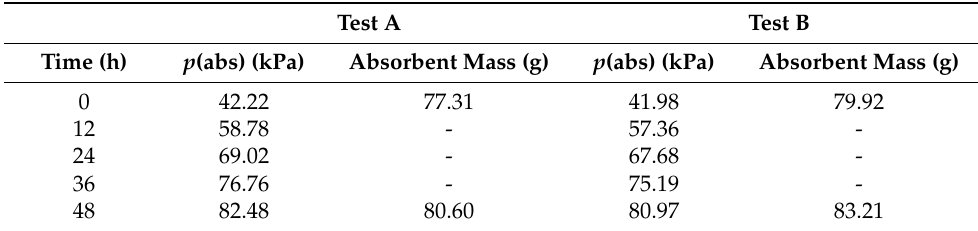
Table 3. Real-time data for repeatability test. Table 3. Real ‐ time data for repeatability test.